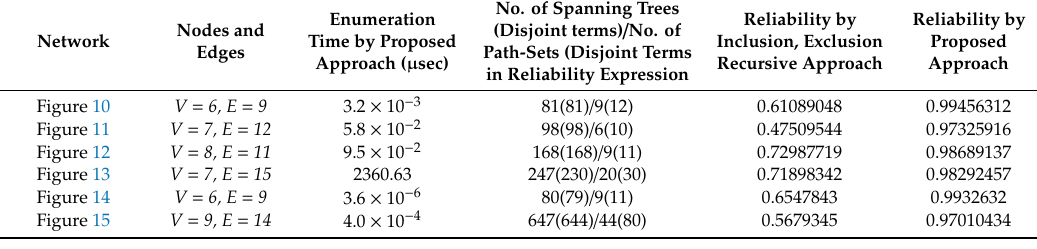
Table 4. Performance and comparison of methods.